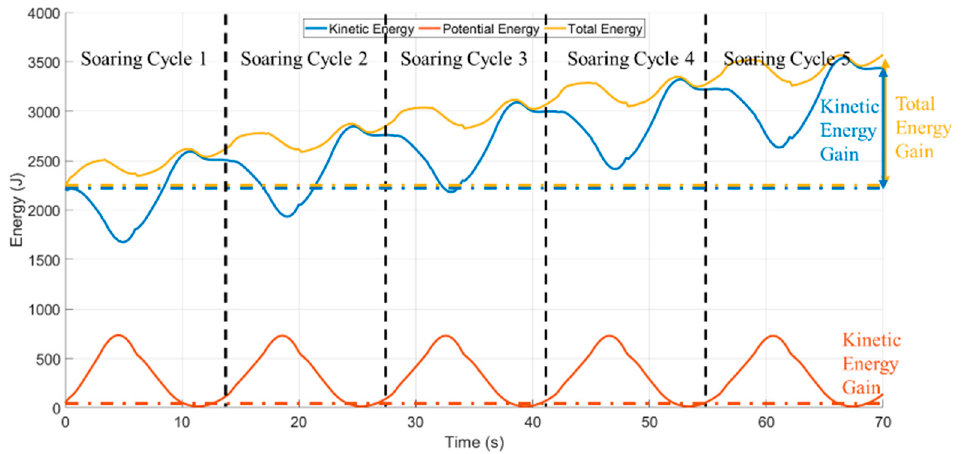
Figure 18. The three energy changes during the dynamic soaring.